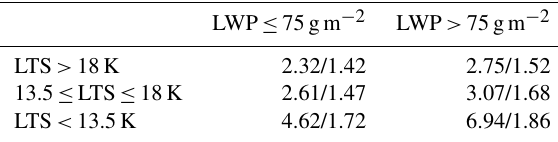
Table 2. Autoconversion (left values) and accretion (right values) enhancement factors in different boundary layer conditions (LTS > 18K for stable, LTS < 13 . 5K for unstable, and LTS within 13.5 and 18K for mid-stable) and in different LWP regimes (LWP ≤ 75gm − 2 for non-precipitating and LWP > 75gm − 2 for precipi-